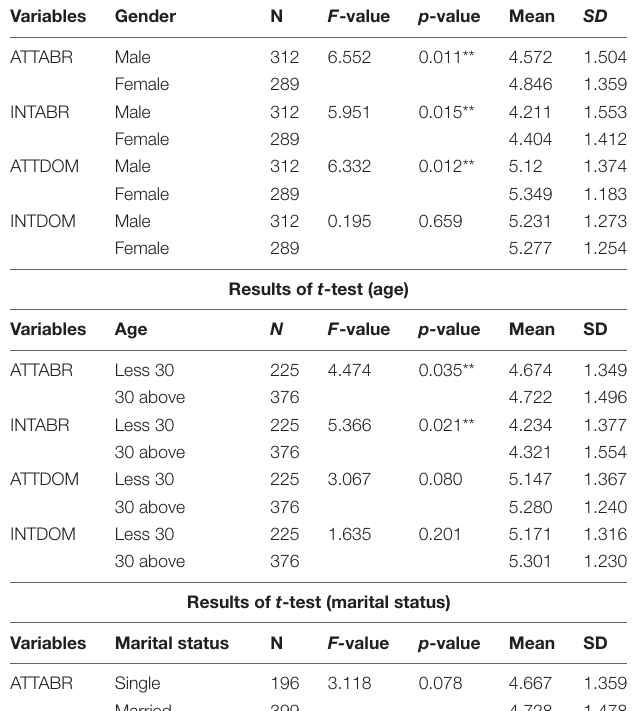
Results of t -test